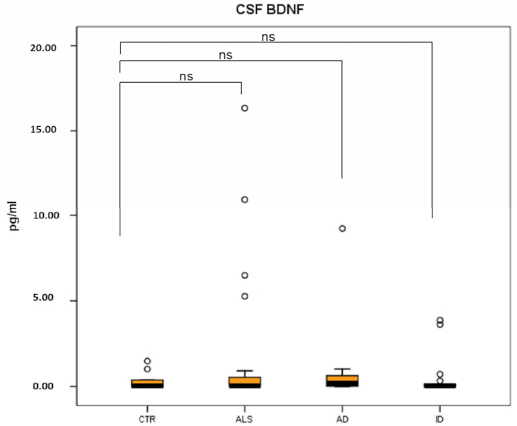
Figure 2. Boxplot showing BDNF levels in CSF of three groups of patients (ALS, AD and ID) and healthy controls (CTR). BDNF levels were not significantly different in ALS patients ( p = 0.964), AD patients ( p = 0.604) and ID patients ( p = 0.711), compared to control subjects. Black horizontal line: median; o: outliers; ns: not